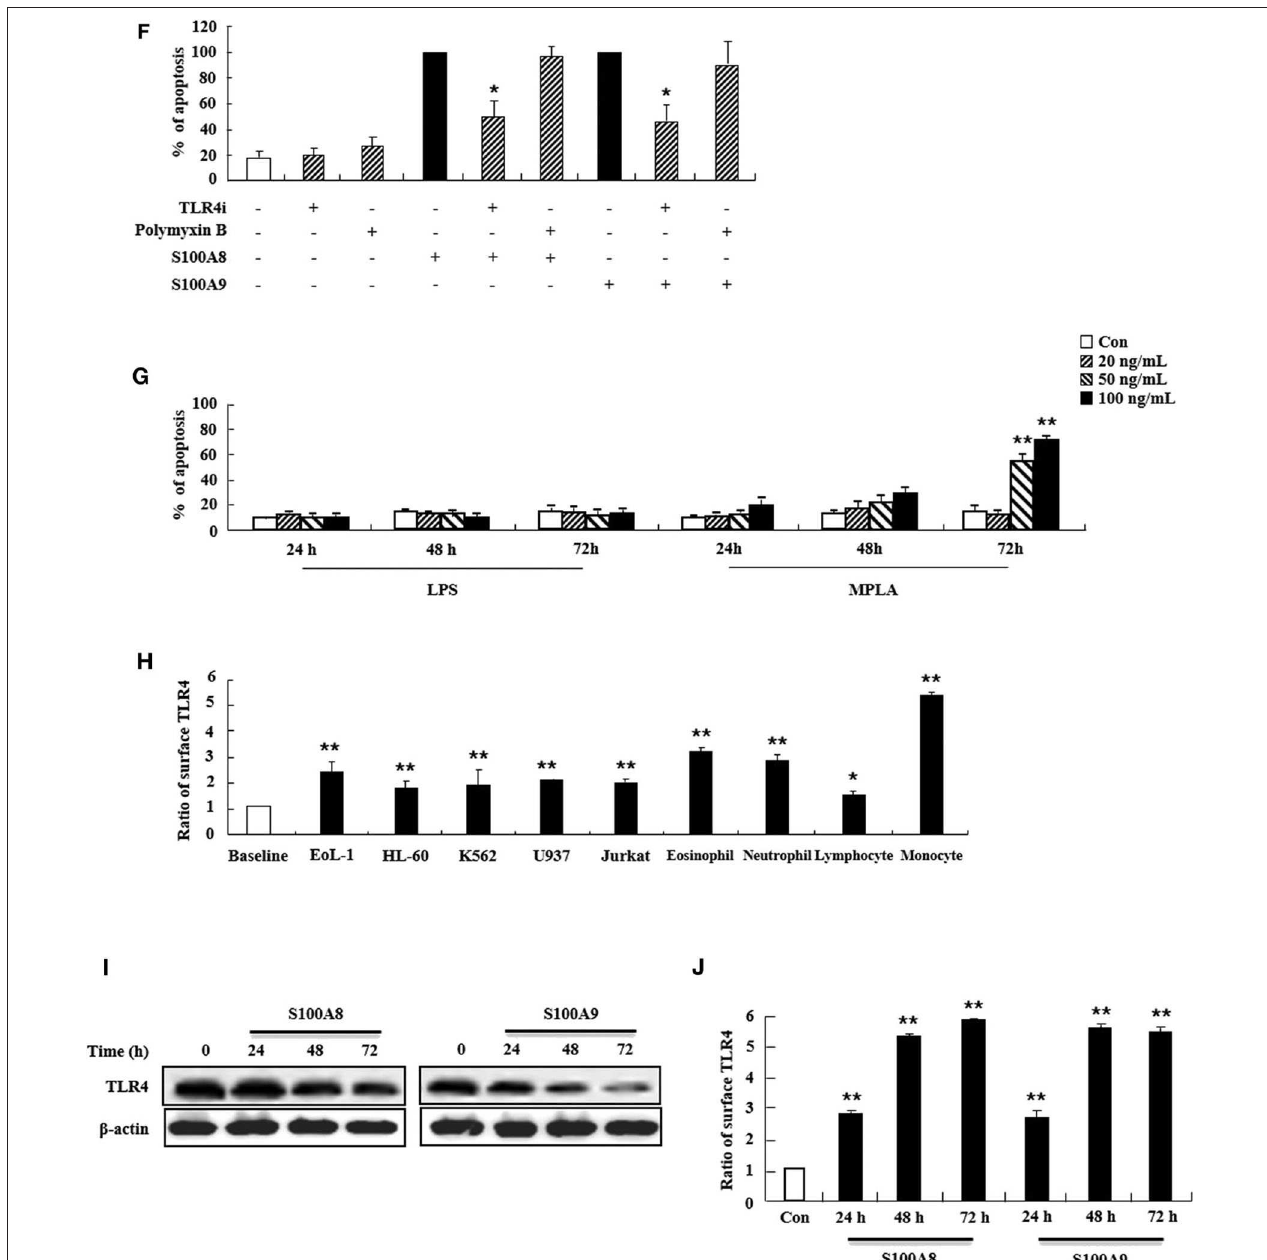
FIGURE 1 | S100A8 and S100A9 induce EoL-1 cell apoptosis via TLR4. (A–D) EoL-1, HL-60, K562, U937, Jurkat cells (A,B) , eosinophils, neutrophils, lymphocytes, and monocytes isolated from normal subjects (C,D) were incubated for 24, 48, or 72h in the absence (Con) or presence of indicated concentrations of S100A8 (A,C) and S100A9 (B,D) (3 < n < 5). (E) EoL-1 cells were pretreated with anti-S100A8 (A8), anti-S100A9 (A9), or rabbit control (Ro) antibodies (2 µ g/mL) and subsequently incubated with S100A8 or S100A9 (10 µ g/mL) ( n = 4). (F) EoL-1 cells were pretreated with or without 1 µ M TLR4 inhibitor (TLR4i) and polymyxin B (10 µ g/mL) for 1h, after which the cells were incubated for 72h in the absence or presence of S100A8 and S100A9 (50 µ g/mL) (3 < n < 5). Data are presented relative to the S100A8- or S100A9-treated group, which is set at 100% (E,F) . Data are expressed as the means ± SD . * p < 0.05 indicates a significant difference between the S100A8- or S100A9-treated group and stimulator-treated groups. (G) EoL-1 cells were treated with indicated concentrations of LPS and MPLA for 24, 48, and 72h ( n = 3). Apoptosis was analyzed by measuring the binding of annexin V-FITC and PI. (H) Flow cytometry was applied to determine TLR4 expression in EoL-1, HL-60, K562, U937, Jurkat cells, and normal eosinophils, neutrophils, lymphocytes, and monocytes without stimulators (3 < n < 5). Baseline fluorescence was obtained by incubating normal rabbit antibodies and was set at 1. (I, J) EoL-1 cells were incubated for 24, 48, and 72h in the absence (Con) or presence of S100A8 and S100A9 (10 µ g/mL) ( n = 3). TLR4 expression was detected using Western blotting (I) and flow cytometry (J) . Data are expressed as the means ± SD . * p < 0.05 and ** p < 0.01 indicate a significant difference between the control and stimulator-treated groups.